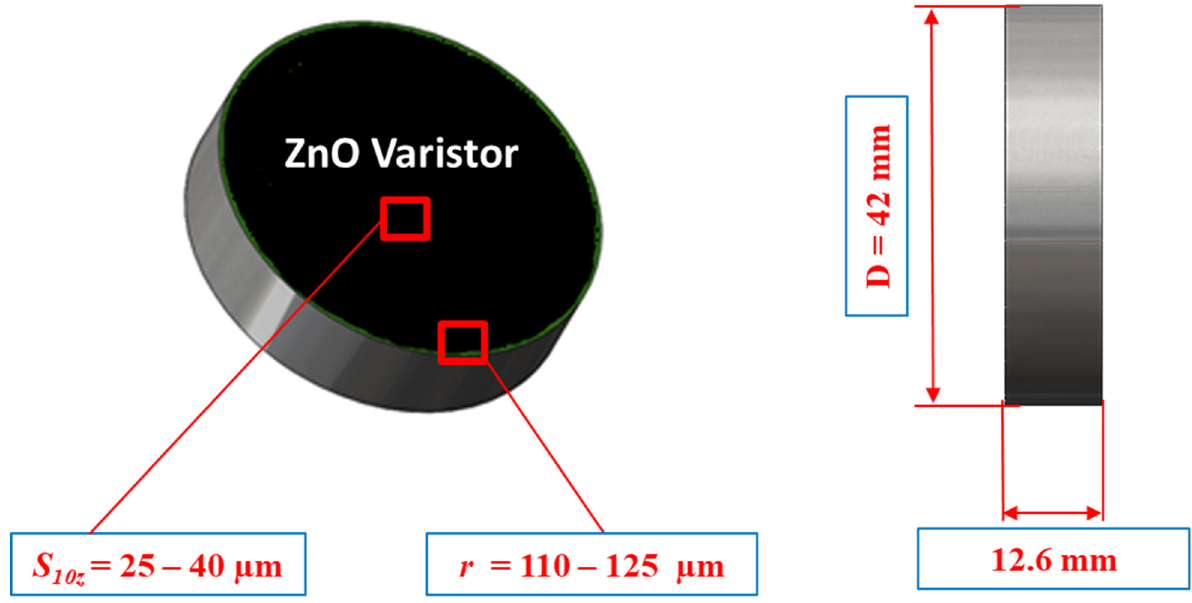
Figure 1. Geometric specifications of the varistor ceramics used in the turning operation.